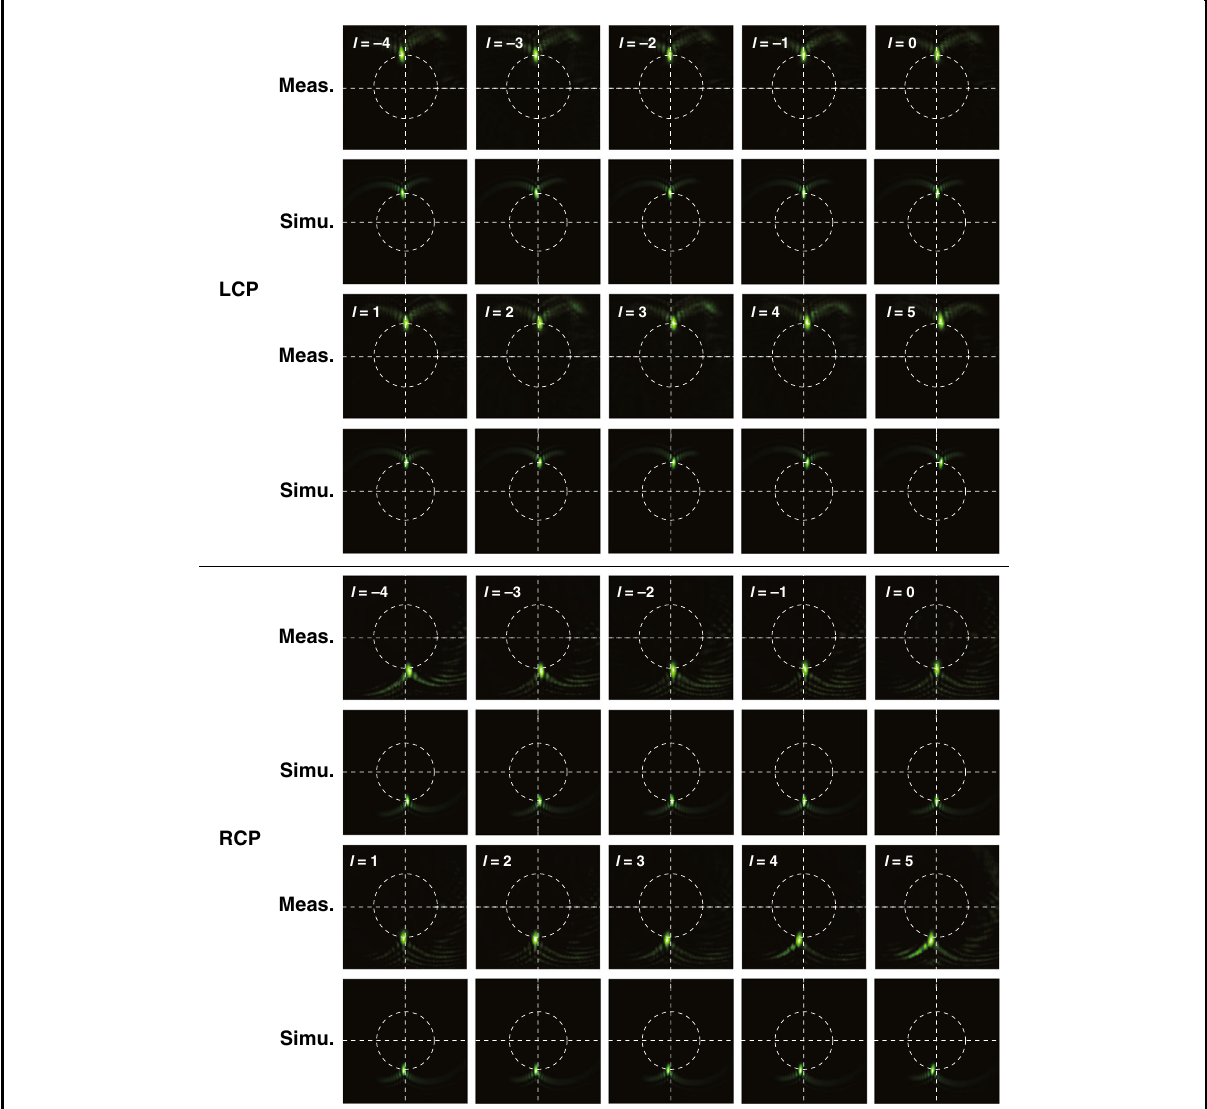
Fig. 4 SAM and OAM sorting at a wavelength of 532 nm. Measured and simulated focusing patterns for different SAMs and OAMs with the topological charge changing from − 4 to